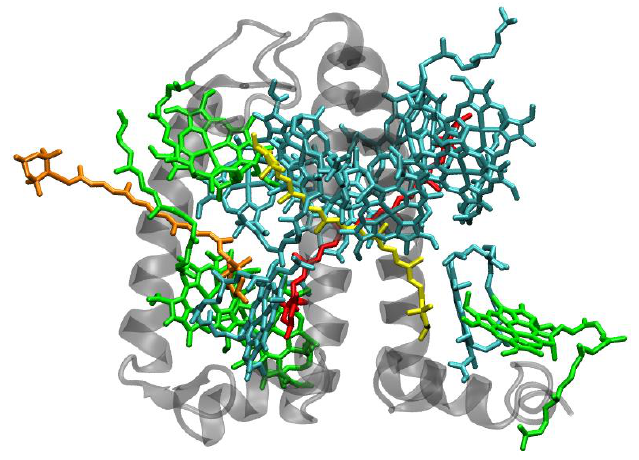
Figure 3. Structure of the monomeric minor light-harvesting complex CP29 of plants at 2.80 Å resolution, PDB entry 3PL9 [36]. Side view with regard to the thylakoid membrane plane. The protein backbone consisting of three transmembrane α -helical domains is shown in grey. CP29 binds 8 chlorophylls a and 4 chlorophylls b (shown in cyan and green, respectively) and has one possible mixed Chl-binding site. Three xanthophylls are bound, one lutein (yellow), one neoxanthin (orange) and one violaxanthin (red). The binding site of the latter may possibly also be occupied by its de-epoxidation products, antheraxanthin or zeaxanthin.